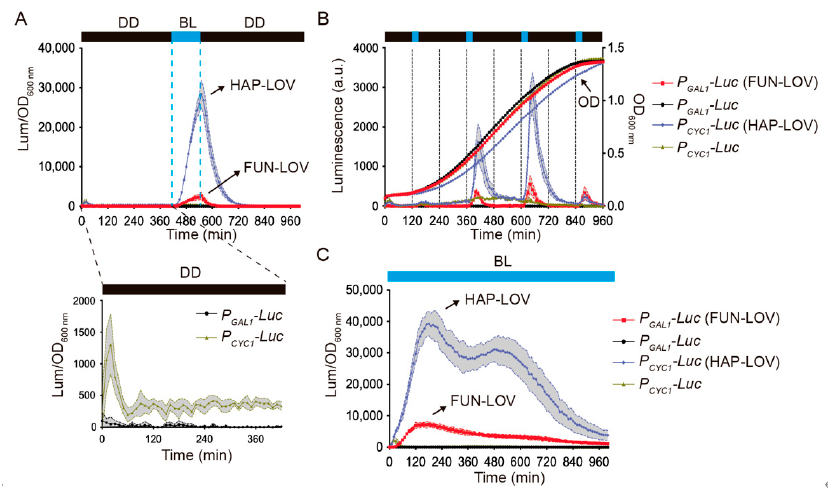
Figure 3. HAP-LOV provides strong and dynamic control of target gene expression. The graphs present changes in the luciferase reporter activity achieved by the FUN-LOV and HAP-LOV optogenetic switches under different illumination regimens. ( A ) Blue-light (BL) pulse of 120 min (dashed lines) for the yeast strains carrying the FUN-LOV and HAP-LOV switches, as indicated. The background luciferase expression prior to the BL pulse has been magnified. The yeast strains carrying the FUN-LOV and HAP-LOV switches were subjected to BL pulses of 30 min every 4 h ( B ) or constant BL illumination ( C ). In panel B, the raw luciferase expression and optical density (OD) at 600 nm is shown for yeast strains carrying the FUN-LOV and HAP-LOV switches. In all panels, the yeast strains carrying the GAL1 ( P GAL1 ) or CYC1 ( P CYC1 ) promoters controlling luciferase ( Luc ) expression, but lacking the corresponding switches, were used as controls. The graphs show the average of raw or normalized luciferase expression in six biological replicates, with the standard deviation represented as a shaded region. Abbreviations: DD, constant darkness; a.u., arbitrary units of luminescence.